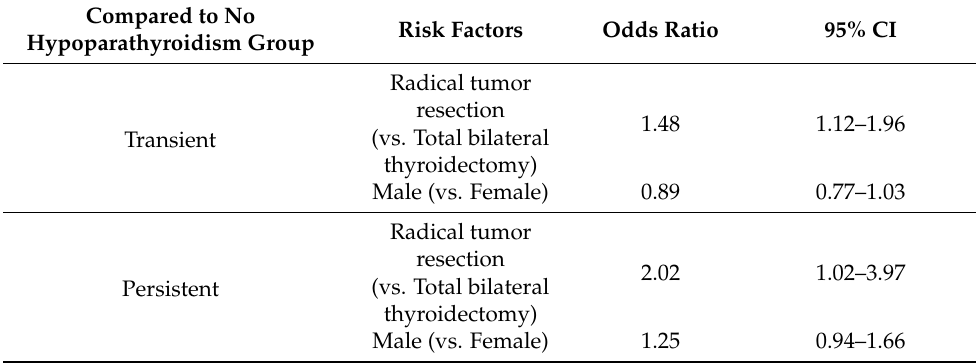
Table 2. Univariate Logistic Analysis of Risk Factors for Transient and Persistent Hypoparathyroidism Compared to the No Hypoparathyroidism